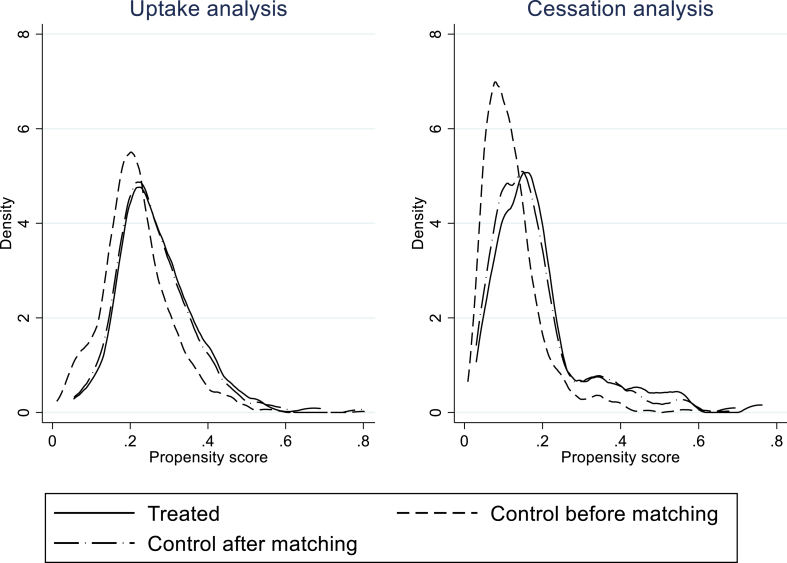
Density plots of propensity scores before and after matching.